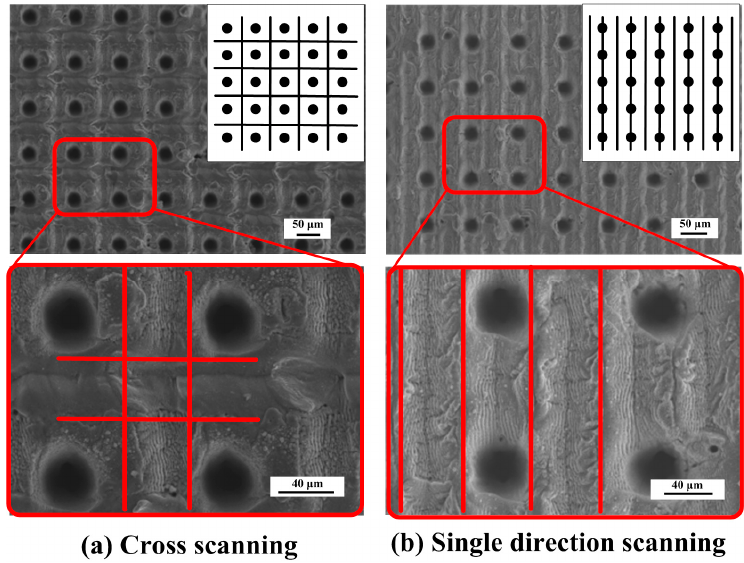
Figure 9. The FE-SEM image of the hierarchical structure with a micro-dimple array and LIPSS: ( a ) Cross scanning; ( b ) single direction scanning.